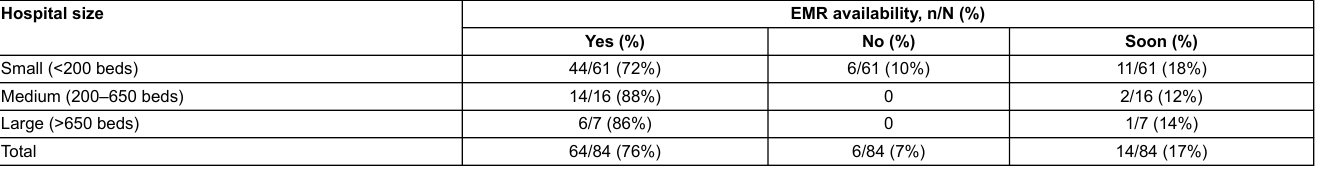
Table 2: Electronic medical record (EMR) availability by hospital size. Hospital